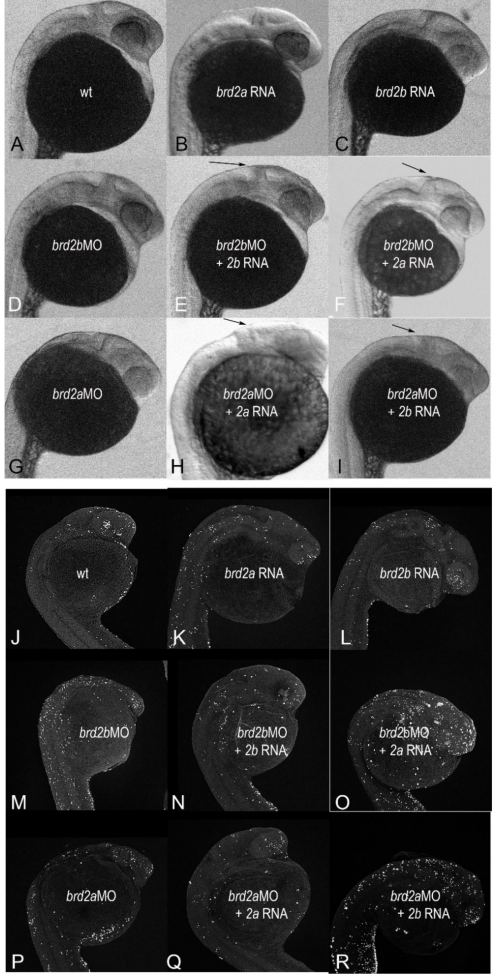
Figure 8. Enhancement of morphant brain phenotypes by injection of paralogous RNA cor- roborates genetic antagonism between brd2a and brd2b. Rescue-Enhancement studies using ze- brafish brd2a and brd2b-L in vitro-synthesized RNAs (rather than human Brd2 ) were used to test functional antagonism between paralogs implied by double knockdown suppression. Panels ( A – I ): Brightfield images of representative 24 hpf prim 5 embryos from indicated treatment groups. For controls: ( A ) uninjected wild type, ( B ) brd2a RNA-injected, and ( C ) brd2b-L RNA-injected. For brd2b MO rescue-enhancement: ( D ) brd2b MO-injected, ( E ) brd 2b MO + brd2b-L RNA co-injected (res- cue), and ( F ) brd2b MO + brd2a RNA co-injection (enhancement). For brd2a MO rescue-enhancement: ( G ) brd2a MO-injected, ( H ) brd2a MO + brd2a RNA co-injected (rescue), and ( I ) brd2a MO + brd2b-L RNA co-injection (enhancement). Arrows indicate rescue ( E , H ) and enhancement ( F , I ) of morphant brain defects by co-injection of cognate or paralogous RNA, respectively. See Table 2 for popula- tion morphology data. Panels ( J – R ): Darkfield images of representative 24 hpf prim 5 embryos from the same treatment groups after TUNEL assay: ( J ) uninjected wildtype, ( K ) brd2a RNA- injected, and ( L ) brd2b-L RNA-injected; ( M ) brd2b MO-injected, ( N ) brd2b MO + brd2b-L RNA co- injected (rescue), and ( O ) brd2b MO + brd2a RNA co-injection (enhancement); ( P ) brd2a MO-injected, ( Q ) brd2a MO + brd2a RNA co-injected (rescue), and ( R ) brd2a MO + brd2b RNA co-injection (enhance- ment). Note rescue ( N , Q ) and enhancement ( O , R ) of morphant excess apoptosis by co-injection of cognate or paralogous RNA, respectively, supporting the idea of functional antagonism between paralogs. See Figure 5 for quantitative TUNEL